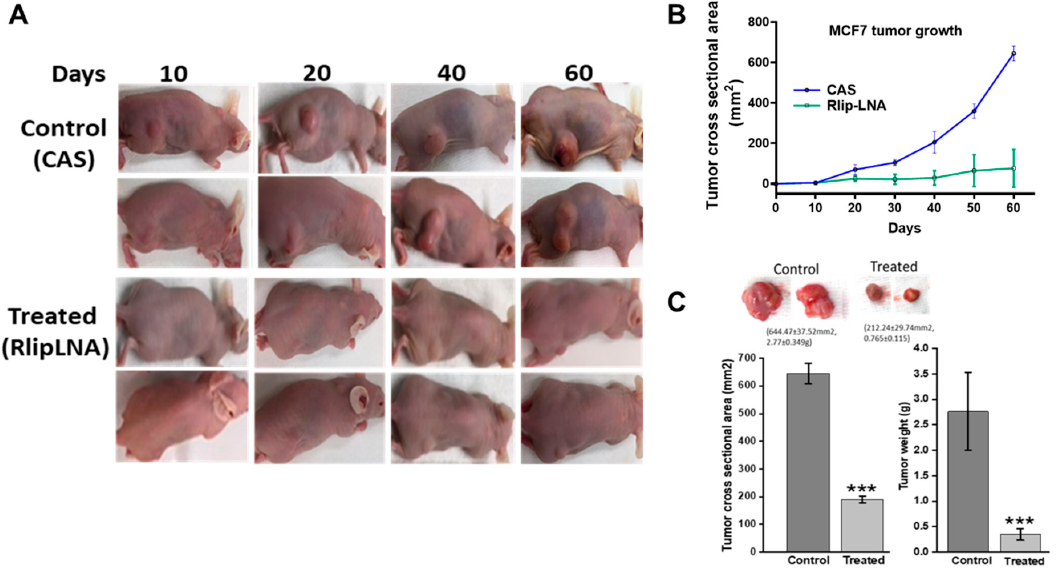
Figure 6. Effect of Rlip-LNA on growth rate of MCF7 tumors. ( A ) Monitoring tumor burden and treatment response. Representative images of the two groups, with two mice from each group (CAS- control and Rlip-LNA-treated) of MCF7-tumor bearing mice. Images are from Day 10 to the end of the study. Tumor weights were determined at the end of the study (Day 60) for each group. Tumor growth was monitored every week, and the tumor sizes were determined using a caliper to measure the tumor cross-sectional area (mm 2 ), calculated in two dimensions using the formula A = (D 1 × D 2 )/2. ( B ) Cross-sectional area of the tumor. Figure shows the growth of tumors in the control and treated groups from Day 10 to the end of the study. ( C ) Histogram shows the tumor cross-sectional areas and tumor weights at the end of the study. Results are reported as mean ± SD. ( n = 5 each group). *** p < 0.001, as compared to the control group of mice, as analyzed by two-tailed Student’s t -test.